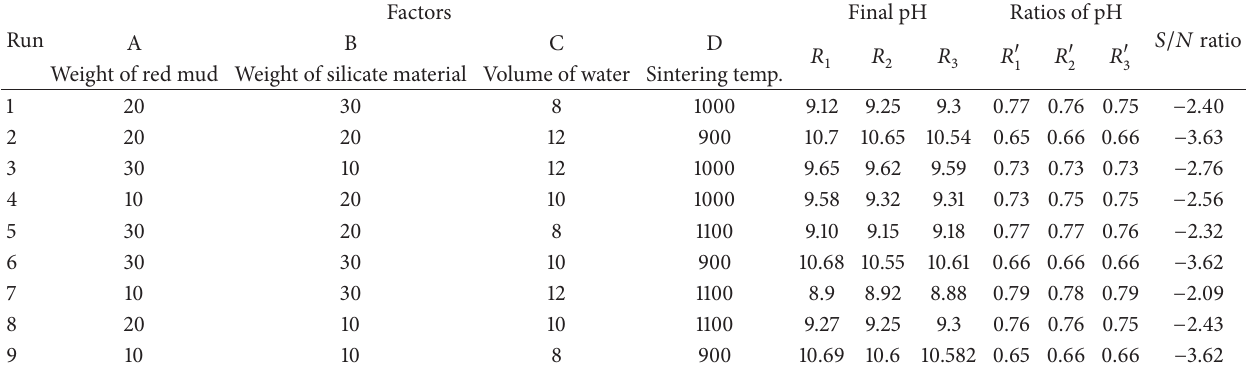
Table 2: 𝐿 9 table and observed values of pH.